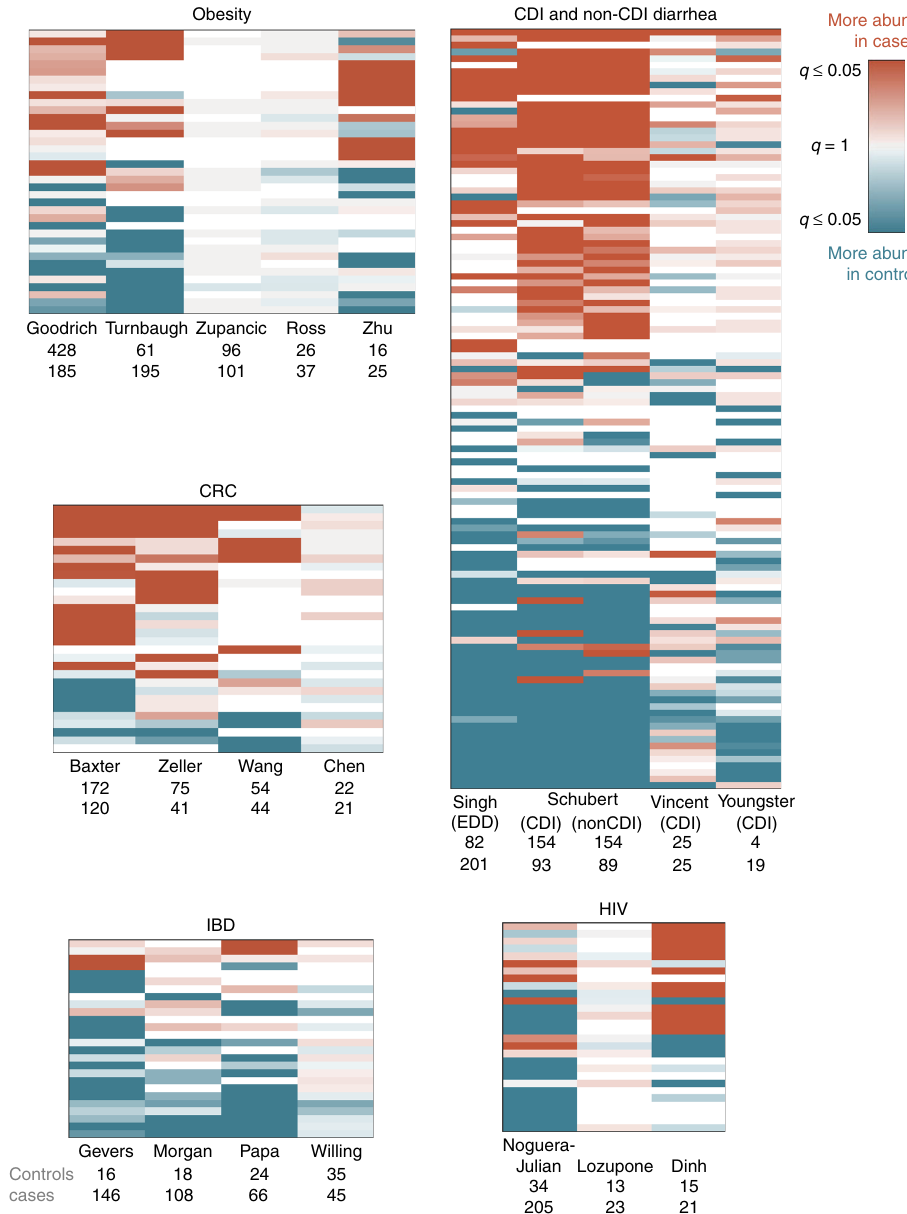
Fig. 2 Comparing results from multiple studies of the same disease reveals patterns in disease-associated microbiome alterations. Heat maps showing log 10 ( q values) for each disease (KW test, Benjamini – Hochberg FDR correction). Rows include all genera which were signi fi cant in at least one data set within each disease, columns are data sets. q values are colored by direction of the effect, where red indicates higher mean abundance in disease patients and blue indicates higher mean abundance in controls. Opacity ranges from q = 0.05 – 1, where q values less than 0.05 are the most opaque and q values close to 1 are gray. White indicates that the genus was not present in that data set. Within each heat map, rows are ordered from most disease-associated (top) to most health-associated (bottom) (i.e., by the sum across rows of the log 10 ( q values), signed according to directionality of the effect). The extent of a disease-associated microbiome shift can be visualized by the number of rows in each disease heat map; the directionality of a shift can be seen in the ratio of red rows to blue rows within each disease. See Supplementary Fig. 2 for genus (row)